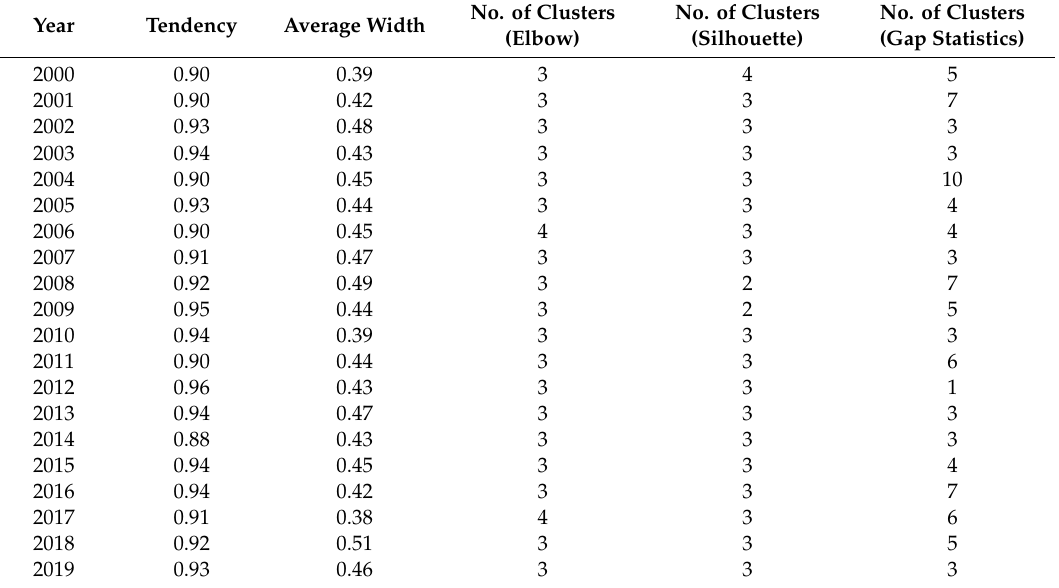
Table 2. Cluster tendency and silhouette width for the optimal number of clusters for each year based on 5000 random samples.